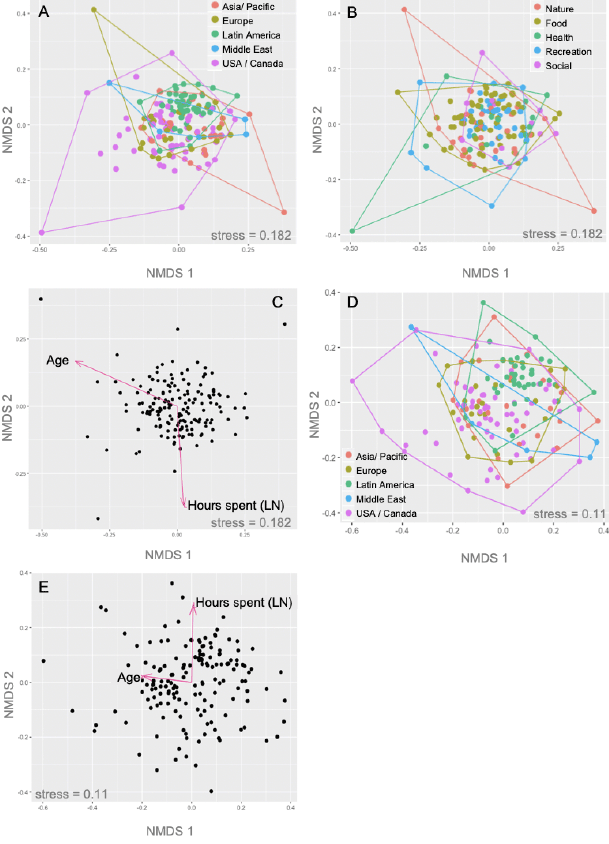
Fig. 3 . Nonmetric multidimensional scaling (NMDS) plots showing distribution of all plant composition based on region of national origin (A), motivations for gardening (B), and based on gardener age, and number of hours spent in the garden (C), and crop composition as a function of region of national origin (D), and gardener age and number of hours spent in the garden (E). All panels show only significant drivers of composition. For panels C and E, each vector points to the direction of most rapid change in its corresponding environmental variable within the ordination space, and vector length indicates the relative strength of the relationship. Significant differences in dispersion and community composition are discussed in the